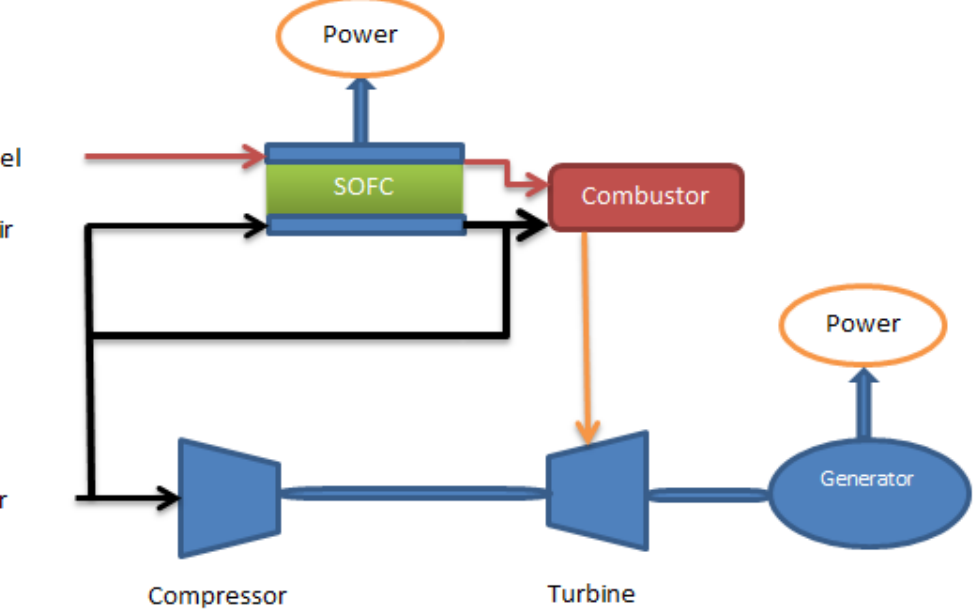
Figure 10. Schematic of a hybrid SOFC/GT system for 0D simulation models.